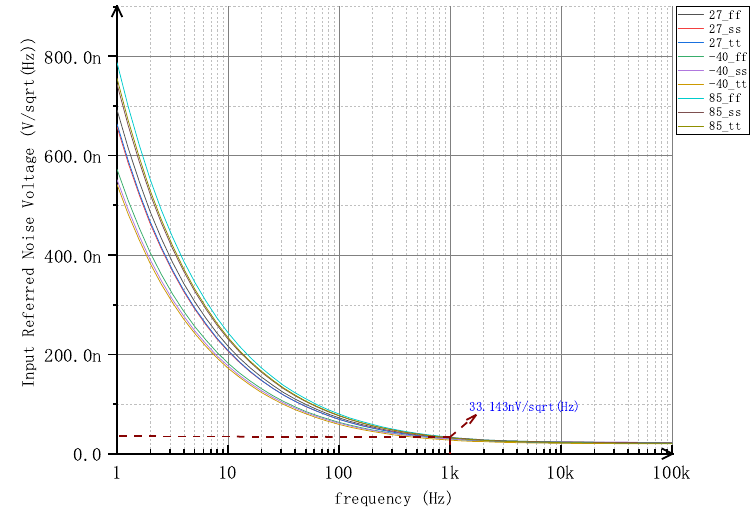
Figure 16. Noise performance of the low noise buffer.